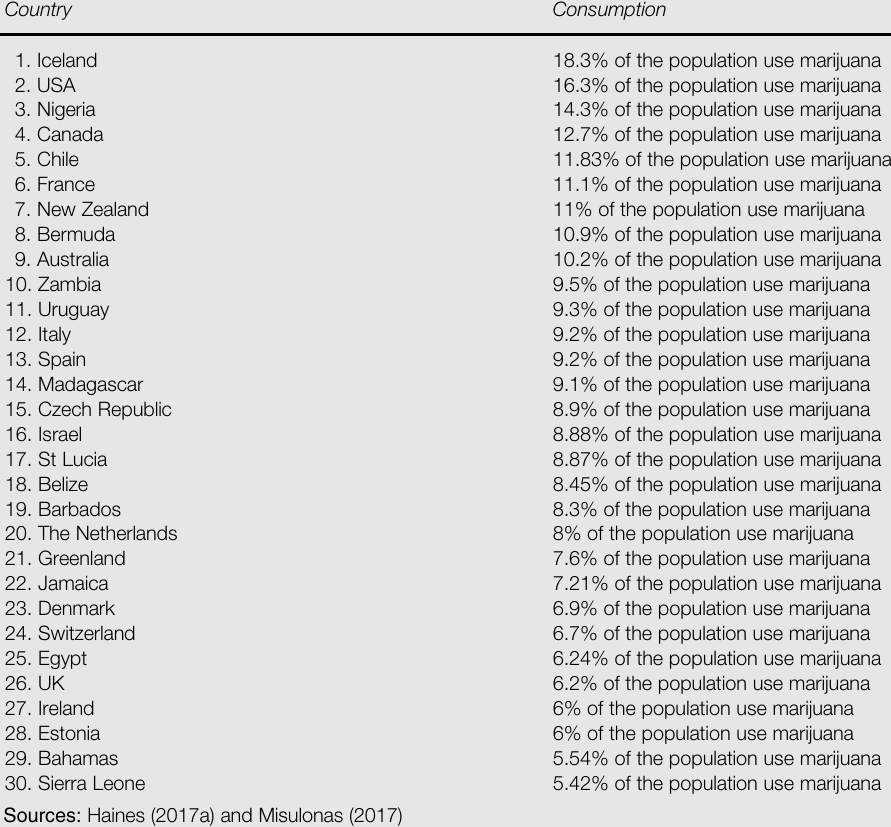
Table I Top countries for cannabis consumption Country